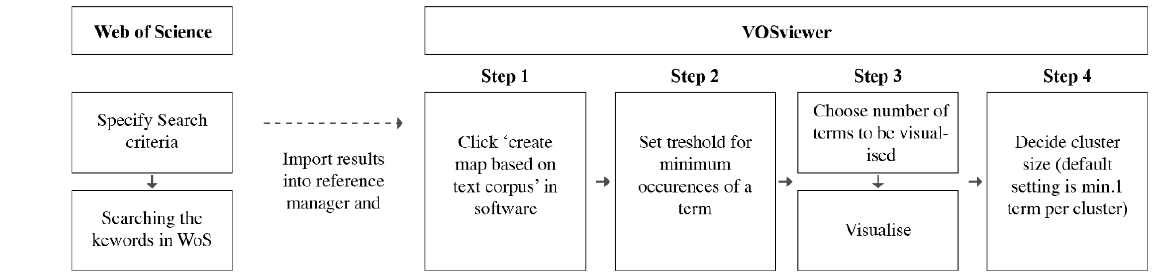
Figure 1. The process of the bibliometric analysis using the VOSviewer.